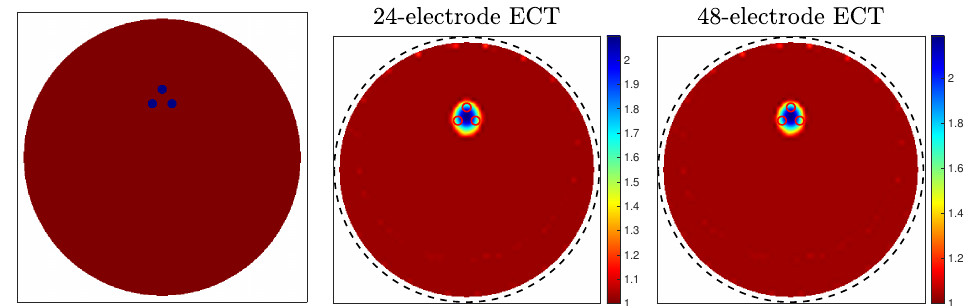
Figure 5. Example considering three very small objects of size below the ECT resolution limit. The leftmost plot shows the ground truth. The middle and right plots show the image reconstruction based on ILM with 24 and 48 electrode sensors, which is nearly identical. ECT cannot individually reconstruct the very small individual objects in this case; rather, it provides a region of interest where the objects